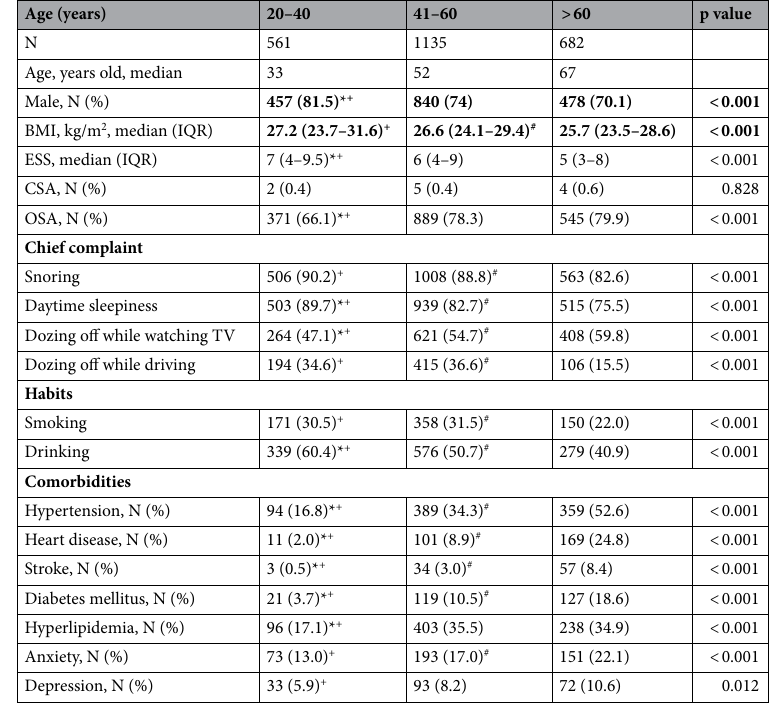
Table 1. Characteristics of enrollees. BMI body mass index, CSA central sleep apnea, ESS Epworth sleepiness score, IQR interquartile range, OSA obstructive sleep apnea. Significant values are given in bold.